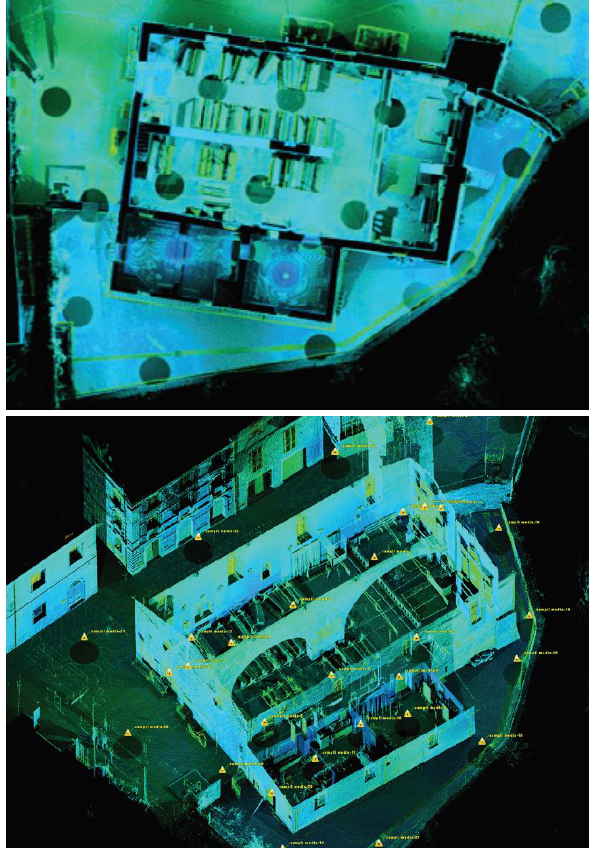
Figure 5 . TLS survey and final point cloud.